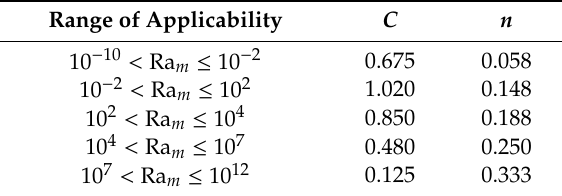
Table 1. Coe ffi cients C and n for the horizontal cylinders [33].